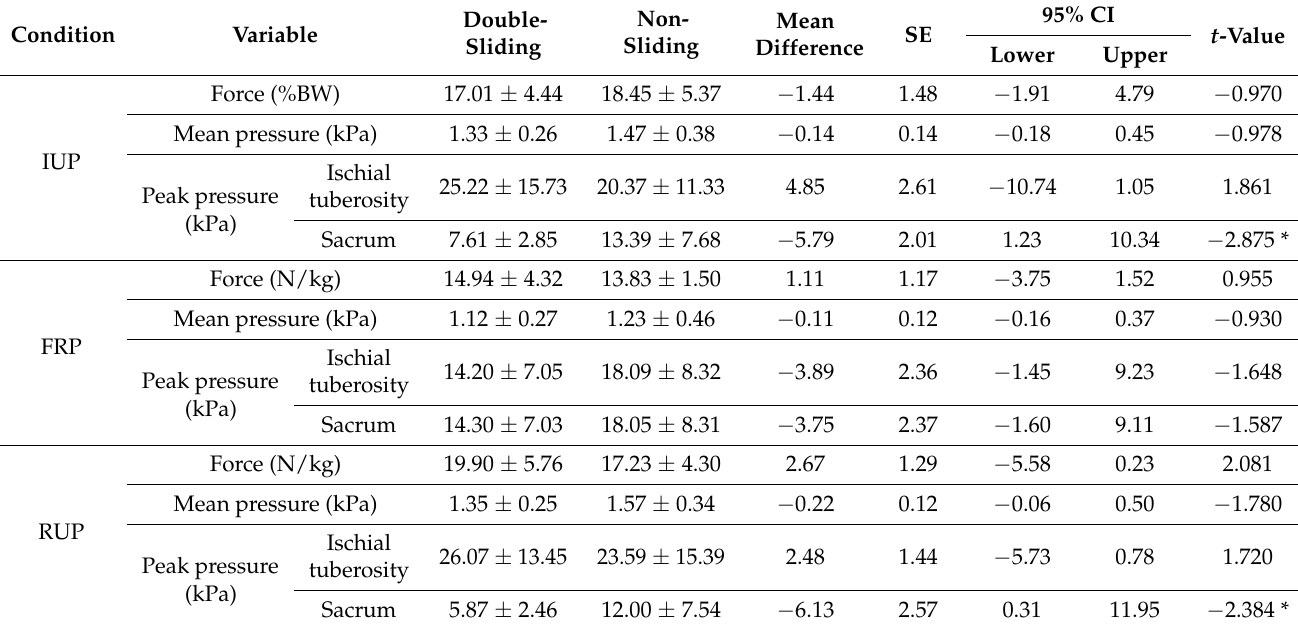
Table 3. Comparison of mean buttock pressure between the two conditions (double-sliding versus non-sliding). Double- Condition Variable Sliding